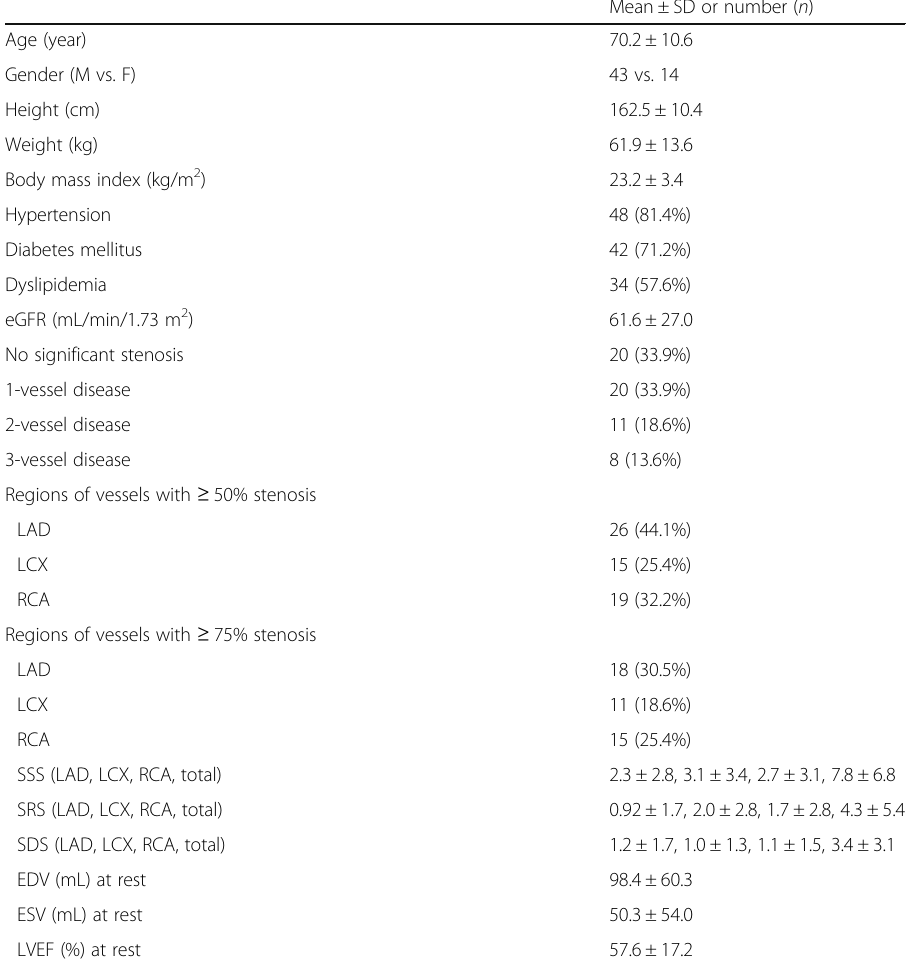
Table 1 Demographics of patients assessed by MP-SPECT and invasive coronary artery angiography